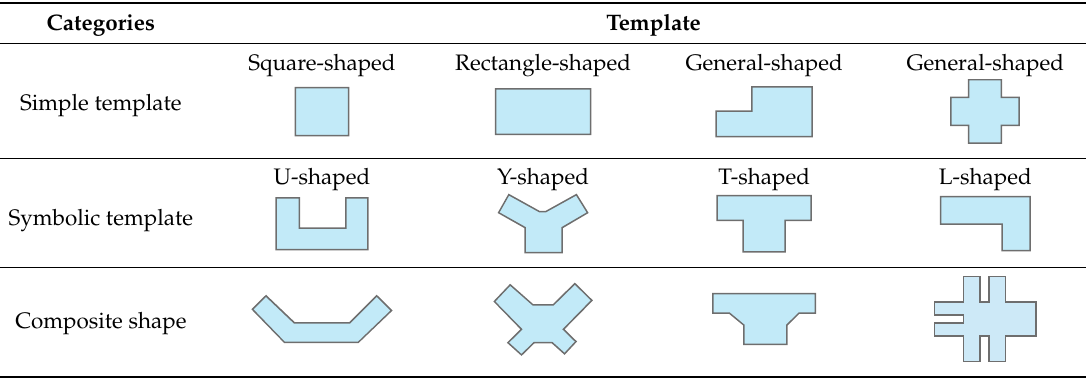
Table 1. Example of a template library for an experimental dataset.